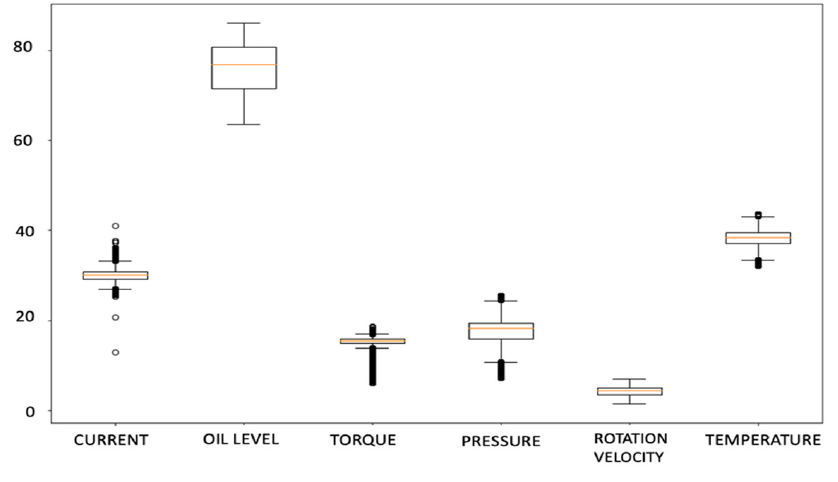
Figure 2. Boxplot of processed